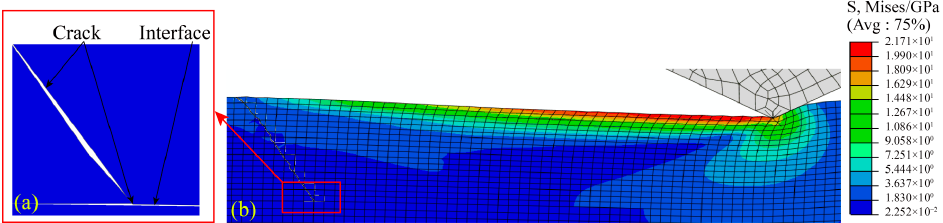
Figure 10. Stress nephogram of the CrN-3Pt coating when the crack propagates to the coating-substrate interface: ( a ) Crack enlargement, ( b ) State of crack.